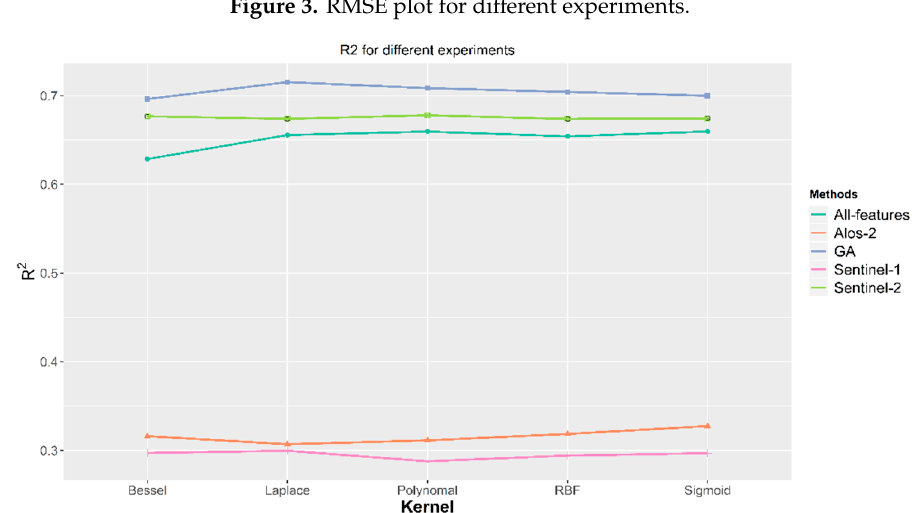
2 plot for di ff erent Figure 4. R 2 plot for different experiments. Figure 4. R Figure 4. R 2 plot for different experiments.